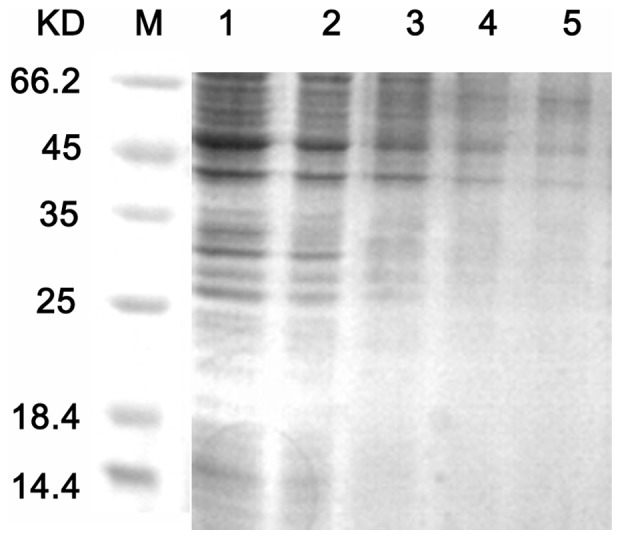
Sodium dodecyl sulfate polyacrylamide gel electrophoresis (SDS–PAGE) analysis of C. michiganense subsp. sepedonicum.Lane 1, untreated C. michiganense subsp. sepedonicum. Lane 2, C. michiganense subsp. sepedonicum cells treated with Fractionation three at 1/2MIC concentration for 8 h. Lane 3, C. michiganense subsp. sepedonicum cells treated with Fractionation three at the MIC concentration for 8 h. Lane 4, C. michiganense subsp. sepedonicum cells treated with Fractionation three at 2MIC concentration for 8 h. Lane 5, C. michiganense subsp. sepedonicum cells treated with Fractionation three at 4MIC concentration for 8 h. Lane M, marker.